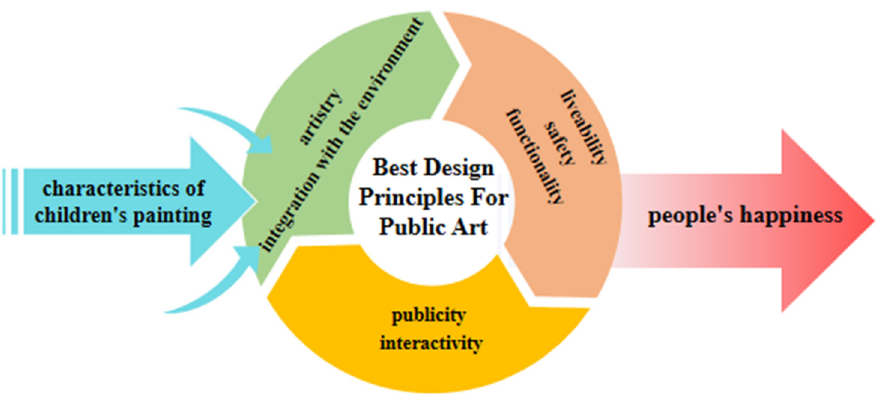
Figure 6. Proposed conceptual framework for design principles of public artworks.